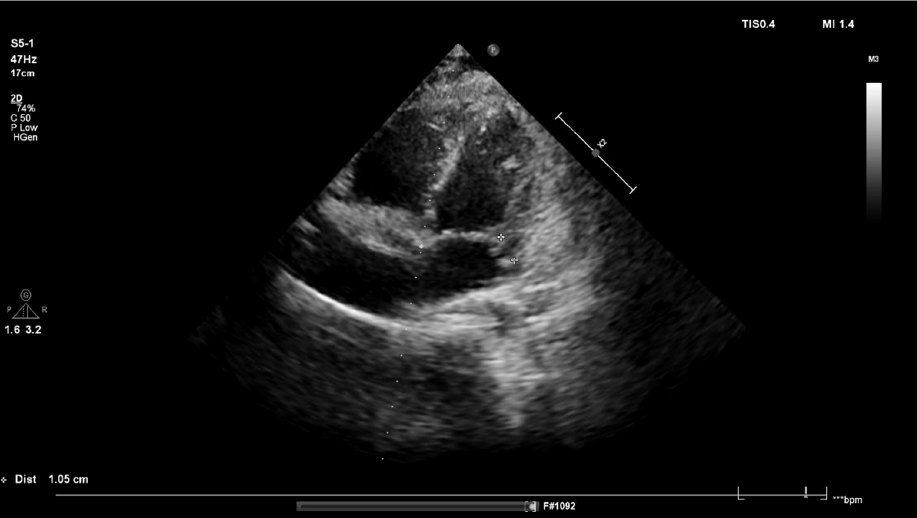
longer visible, as confirmed by transesophageal echocardiography.